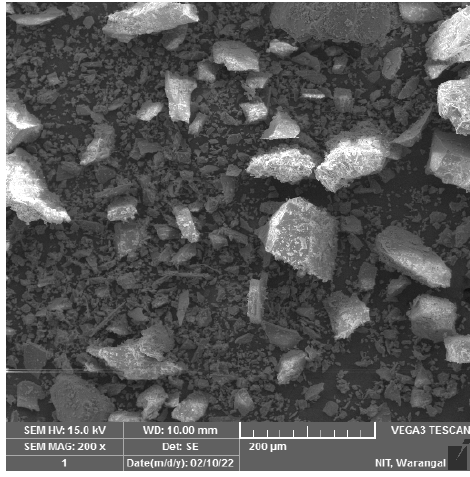
Figure 2. SEM image of GS.